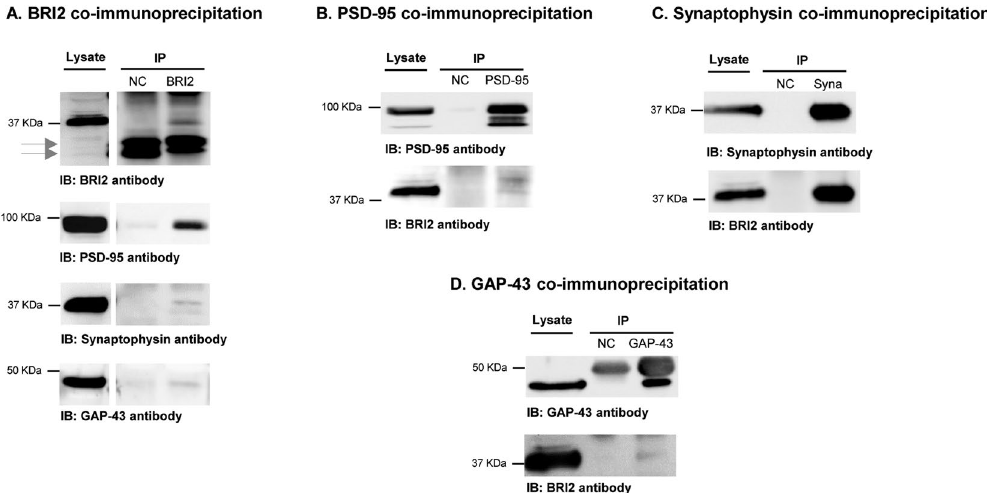
Figure 5. Co-immunoprecipitation of BRI2, PSD-95, synaptophysin and GAP-43 in rat cerebral cortex lysate. Rat cerebral cortex lysate was immunoprecipitated with a mouse monoclonal BRI2 antibody ( A ), a mouse monoclonal PSD-95 antibody ( B ), a mouse monoclonal synaptophysin antibody ( C ) and a rabbit polyclonal GAP-43 antibody ( D ) bound to protein G dynabeads. The mock IP negative controls were performed by incubating cell extracts with G Dynabeads coupled with mouse IgG or rabbit IgG. NC, mock IP negative controls. Arrows indicate BRI2 N-terminal fragments detected in brain